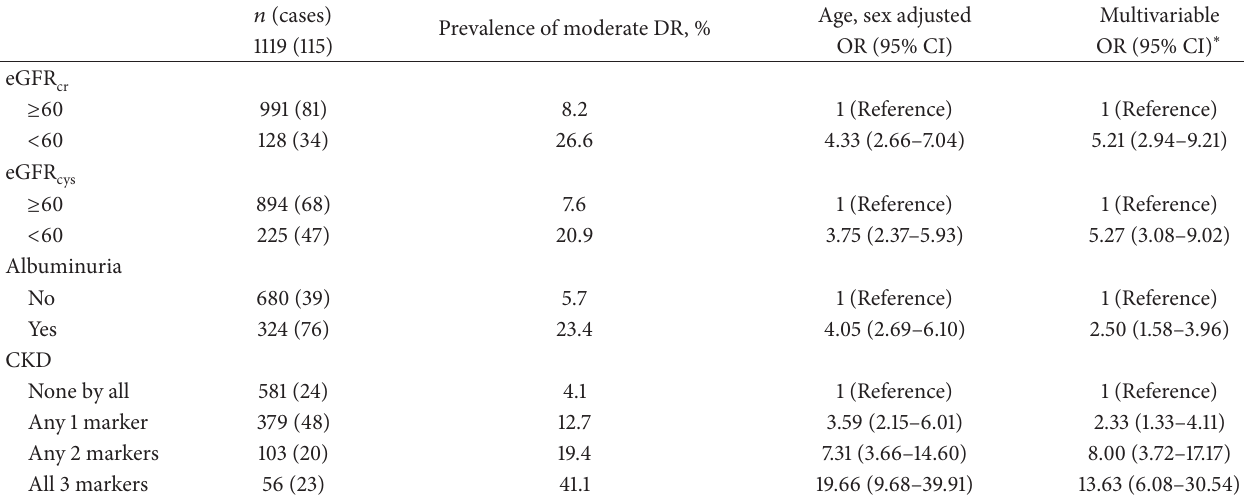
Table 2: Association between markers of CKD and moderate DR in the study